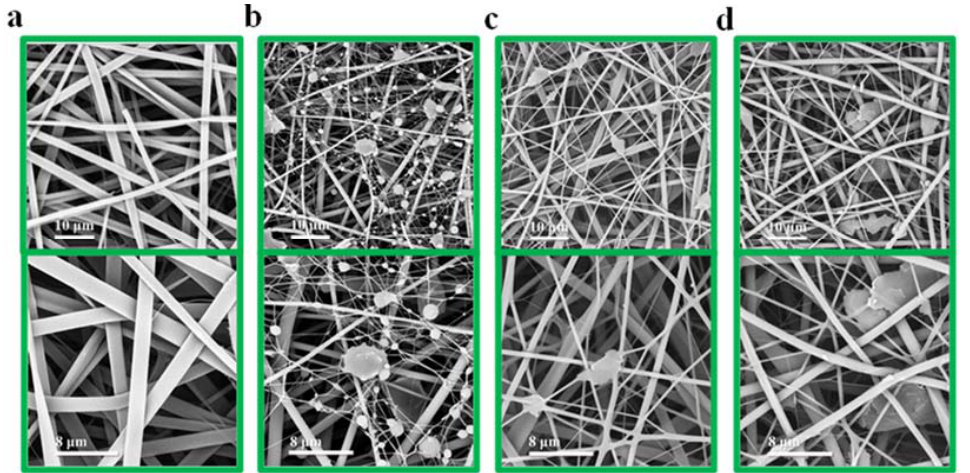
Figure 1. ( a ) SEM images of pure SF nanofiber membrane and SF/Gr nanofiber membranes. The concentration of Gr is ( b ) 10 mg/mL, ( c ) 15 mg/mL, and ( d ) 20 mg/mL, respectively. Magnify 5000 and 10,000 times, respectively.